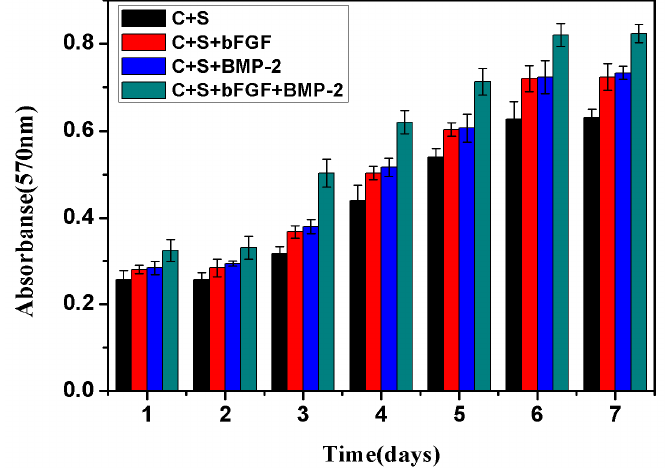
Figure 3. Four groups of cell proliferation were analyzed by alamarBlue assay: C + S, BMSCs/scaffold; C + S + bFGF, BMSCs/bFGF/scaffold; C + S + BMP-2, BMSCs/BMP-2/scaffold; C + S + bFGF + BMP-2, BMSCs/bFGF/BMP-2